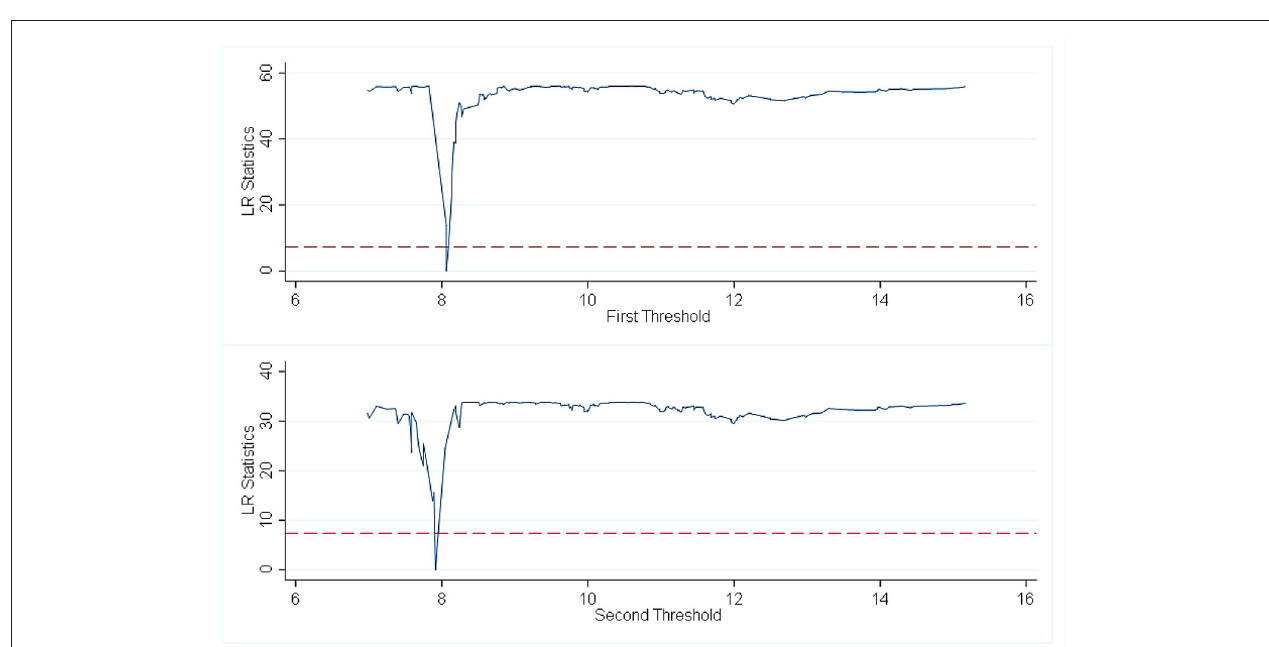
FIGURE 5 | Thresholds return to high-development areas of the digital economy dual threshold